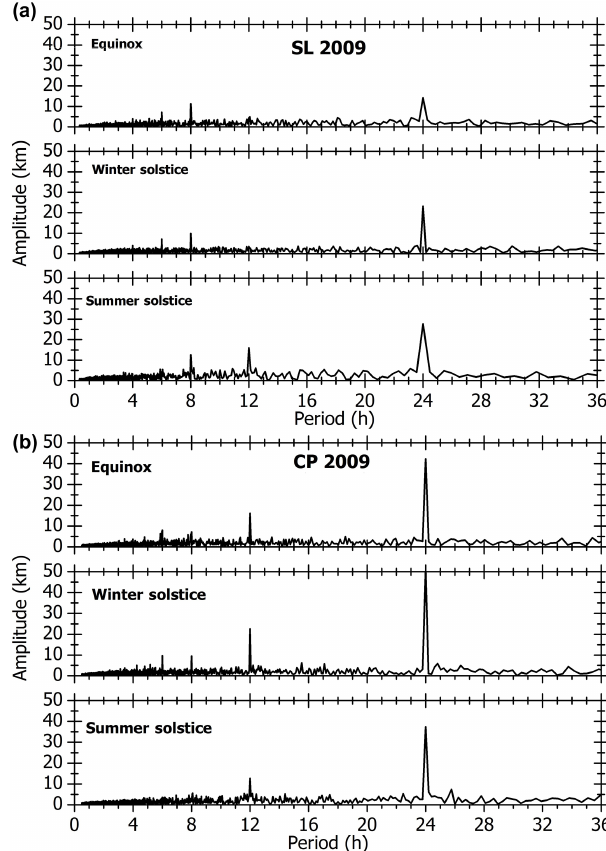
Figure 6. Period amplitude of the intermediate layer heights ob- tained from the FFT analysis for SL (a) and CP (b) during